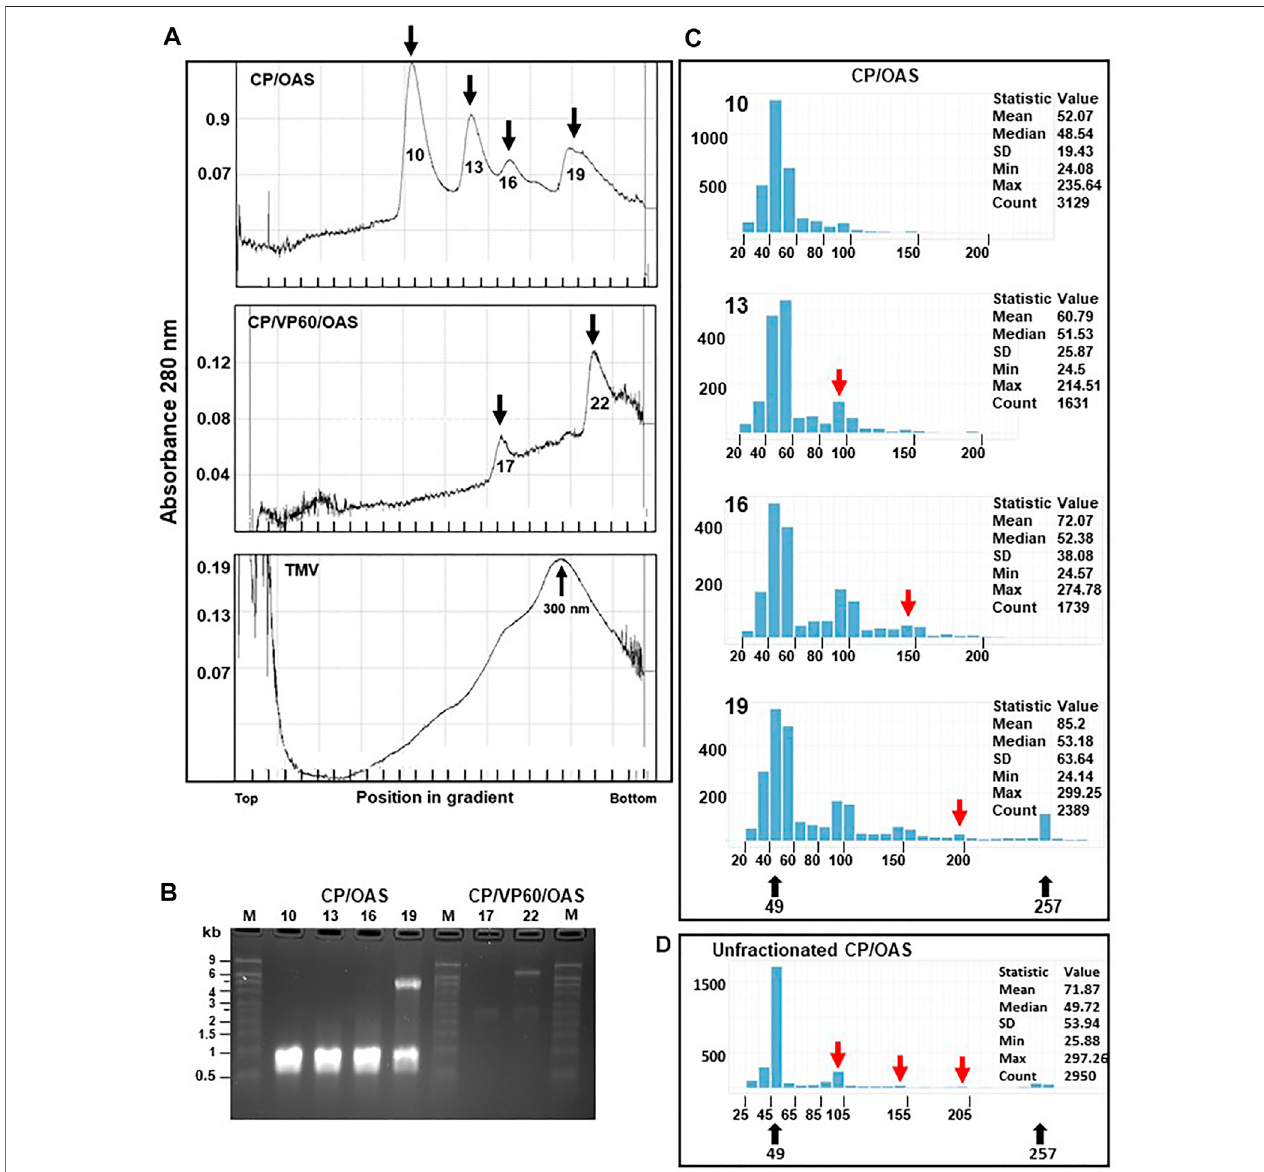
FIGURE 3 | Distinctive size classes of nanorods can be separated by sucrose-density gradient ultracentrifugation centrifugation. (A) CP/OAS nanorods, upper panel, CP/VP60/OAS nanorods, middle panel and TMV lower panel separated on a 15 – 30% sucrose density gradient and fractionated. Y axes, absorbance (280 nm) measuredduringfractionation. Fractions, 10,13,16and19( X axis)correspondingtomeasurementpeaks aremarkedbyarrows, upper panel,andsimilarlyfractions17 and22,middlepanel.Lowerpanel,TMVwiththeviruspeakmigrationindicatedat300 nm. (B) Ethidiumbromide-staineddenaturingagarosegelofRNAextracted from fractions indicated in (A) . M, RNA size ladder. (C) Histograms, output of the Nanorod UI interface, showing the length distribution of nanorods from computer- automated measurements ofTEM images for CP/OAS fractions 10, 13, 16 and 19. The nanorod expected lengths 49 and 257 nm are indicated below. Y axes, number ofnanorodsineachsizeclass; X axes,lengthdistributionsin10 nmincrements.Theexpectedlengthofnanorodsderivedbyend-to-endformationof49 nmnanorodsis shown, red arrows. The descriptive measurement statistics (including mean, median, standard deviation; minimum and maximum length and total count) is shown for each histogram. (D) Histogram showing the length distribution of particle lengths from computer-automated measurements of TEM images for CP/OAS unfractionated nanorods.